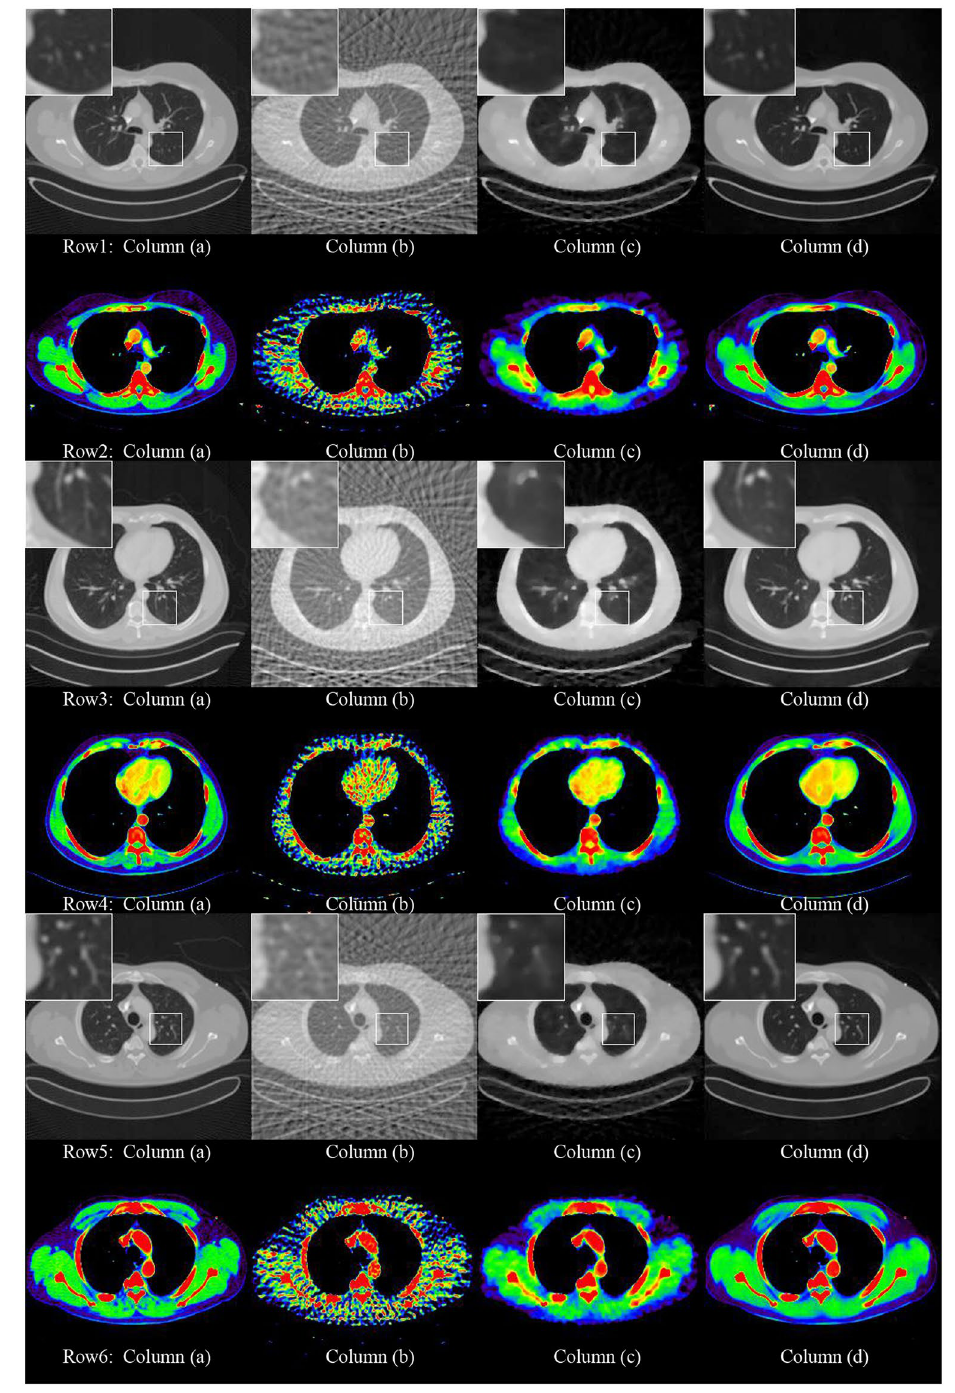
Figure 2. The 512 * 512 CT images reconstructed by 60 projection views. Column ( a ) shows the reconstruction by the FBP method from the full projection views. Column ( b ) shows the reconstruction by the FBP method from the sparse projection views. Column ( c ) shows the reconstruction by the ADS-POCS method from the sparse projection views. Column ( d ) shows the reconstruction by the proposed method. All images display in the same window at row 1, 3 and 5. In order to compare the CT value with different reconstruction method, we use 2D atlas to display. The results are shown in row 2, 4 and